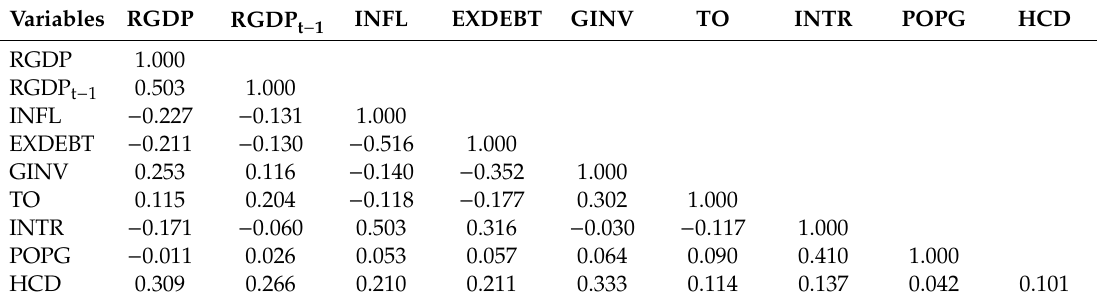
Table 2. Correlation matrix of the variables in the sample.